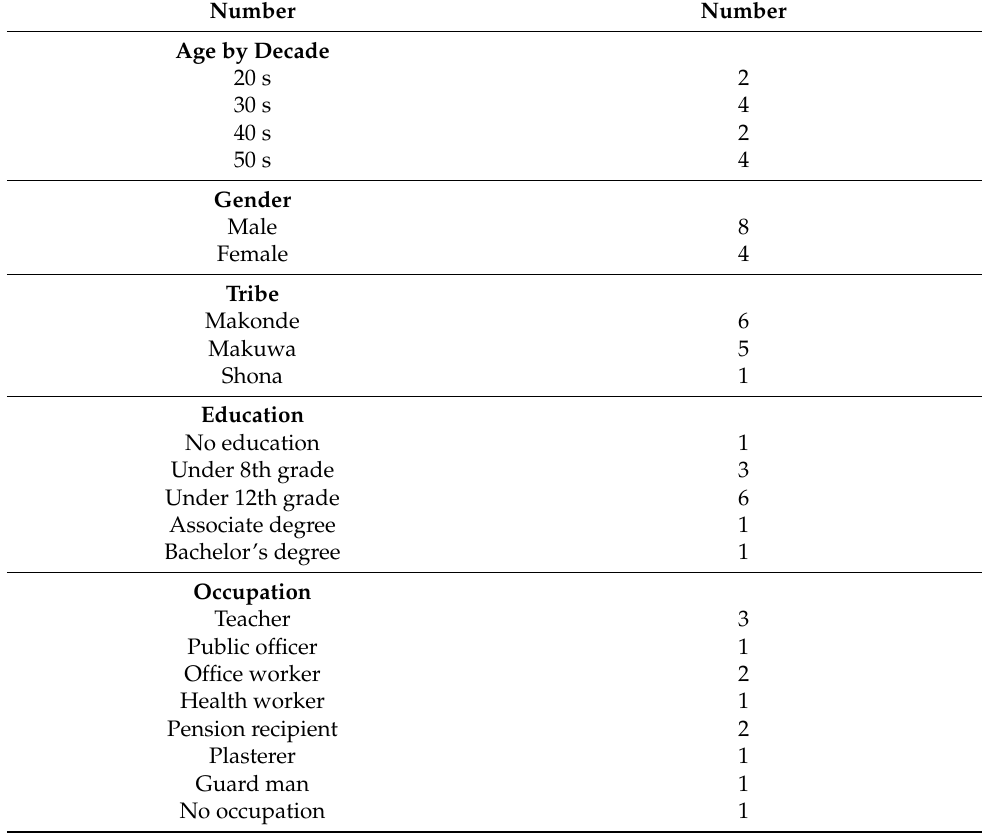
Table 2. Socio-demographic characteristics of informants ( n =